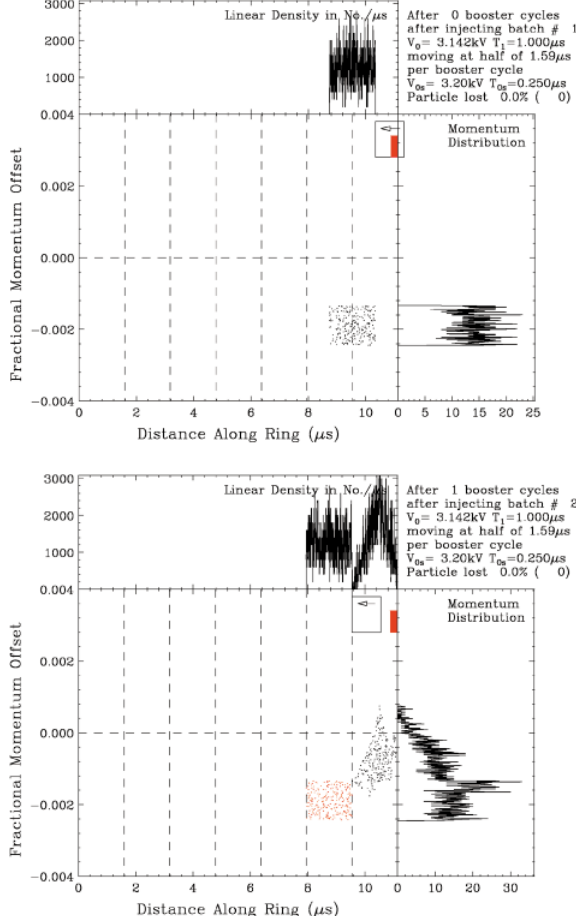
FIG. 6. (Color) Top: First batch (black) is injected between 5.5 T b and 6.5 T b with the right side touching the left side of the moving barrier, illustrated as an unfilled box with an arrow. Bottom: After one booster cycle, all particles in the first batch have just cleared the left side of the moving barrier, which is at 6.0 T b . The second batch (red) is now injected between 5.0 T b and 6.0 T b . The moving barrier has a width of T 1 (cid:1) 1.0 m s and a strength of V (cid:1) 3.1421 kV. Vertical dashed lines are spaced at T b .